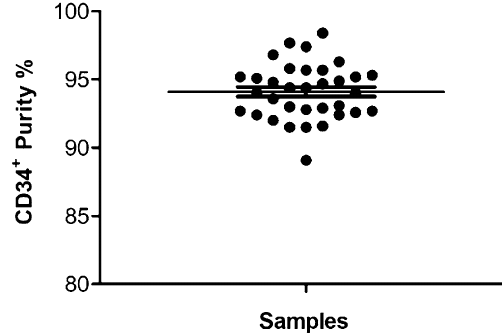
Figure 6. The spread in purity of the CD34 + samples as measured with the BD Accuri™ C6 flow cytometer. The average purity of the CD34 + cells was 94.11%. The error bar represents the standard error of the mean (SEM) of the different isolated samples (n =